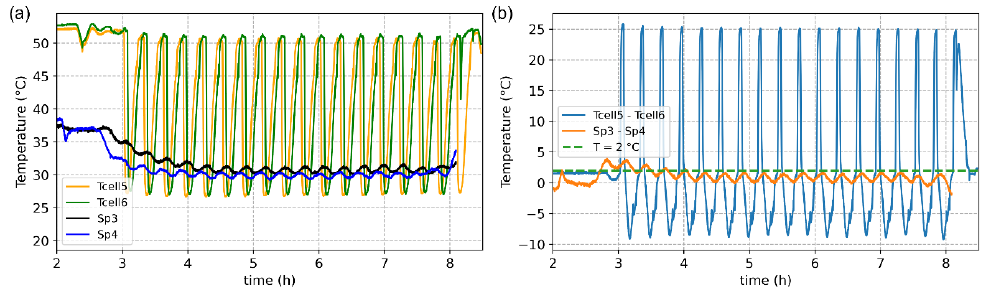
Figure 7. Temperature profiles of ( a ) Cell5, Cell6, Sp3, and Sp4, and ( b ) temperature difference between Cell5 and Cell6, and between Sp3 and Sp4.